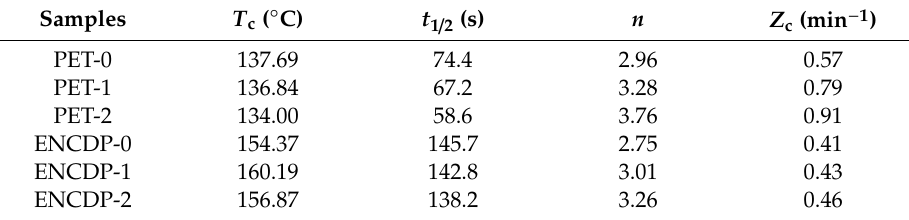
Table 8. The parameters of non-isothermal crystallization from Avrami analysis.